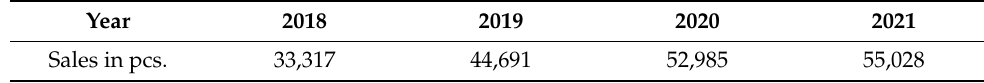
Table 1. Sales of the product “Tooth harrow (200